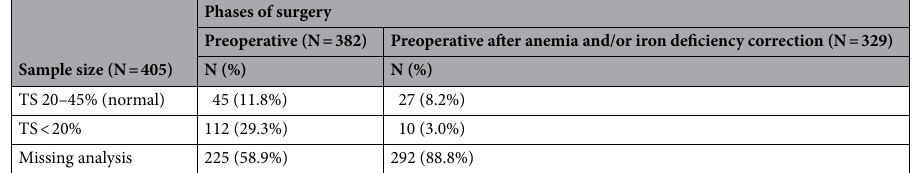
Sample size (N = 405)